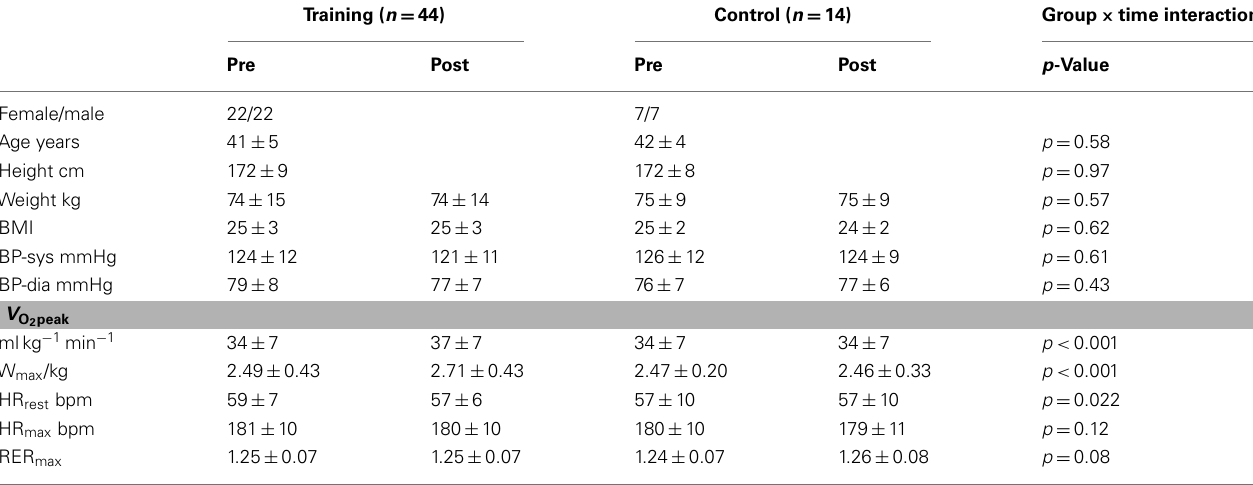
Table 1 |The effects of